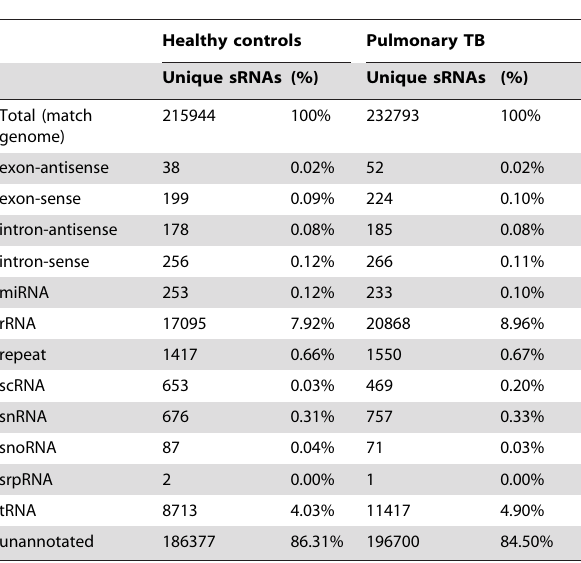
Table 2. The categories of small RNAs in pooled serum samples from pulmonary TB patients and healthy controls by Solexa sequencing